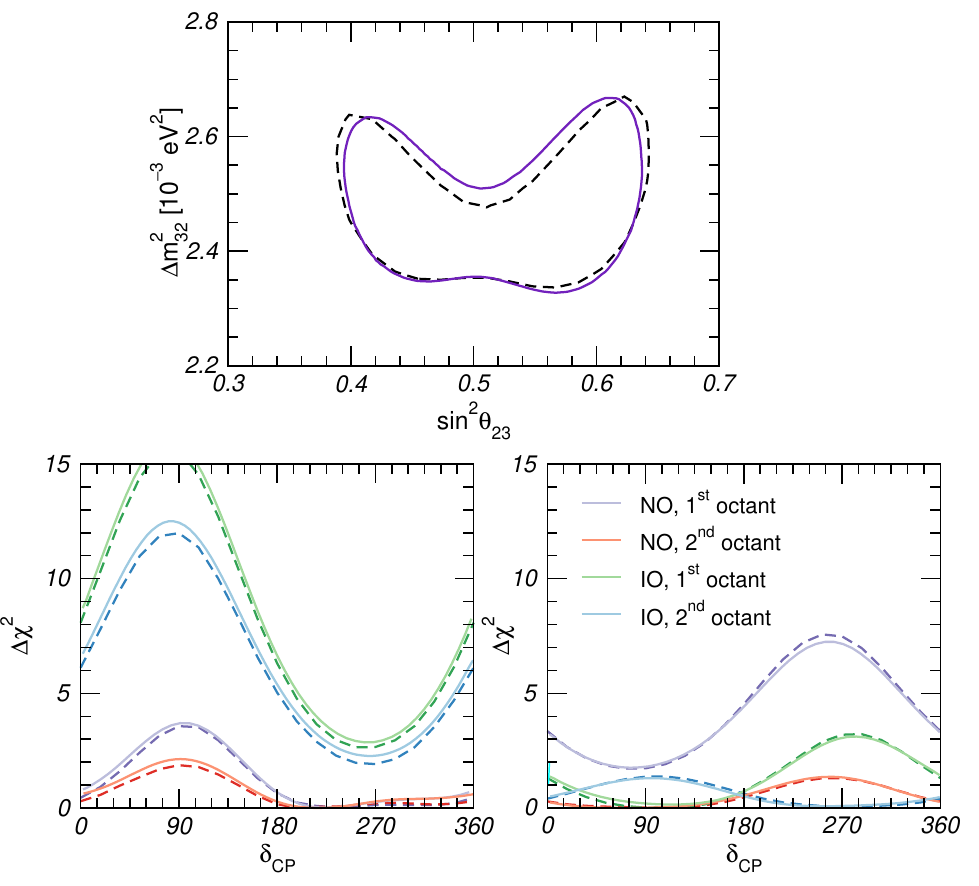
Figure 13 . Di(cid:11)erent projections to our (cid:12)t to latest NOvA data (dashed lines) compared to the corresponding results of the experimental collaboration (solid curves), as presented in ref. [46], when adopting the same assumptions. The upper plot only includes disappearance data, whereas the bottom left plot corresponds to (cid:23) e appearance and the bottom right plot to (cid:22) (cid:23) e